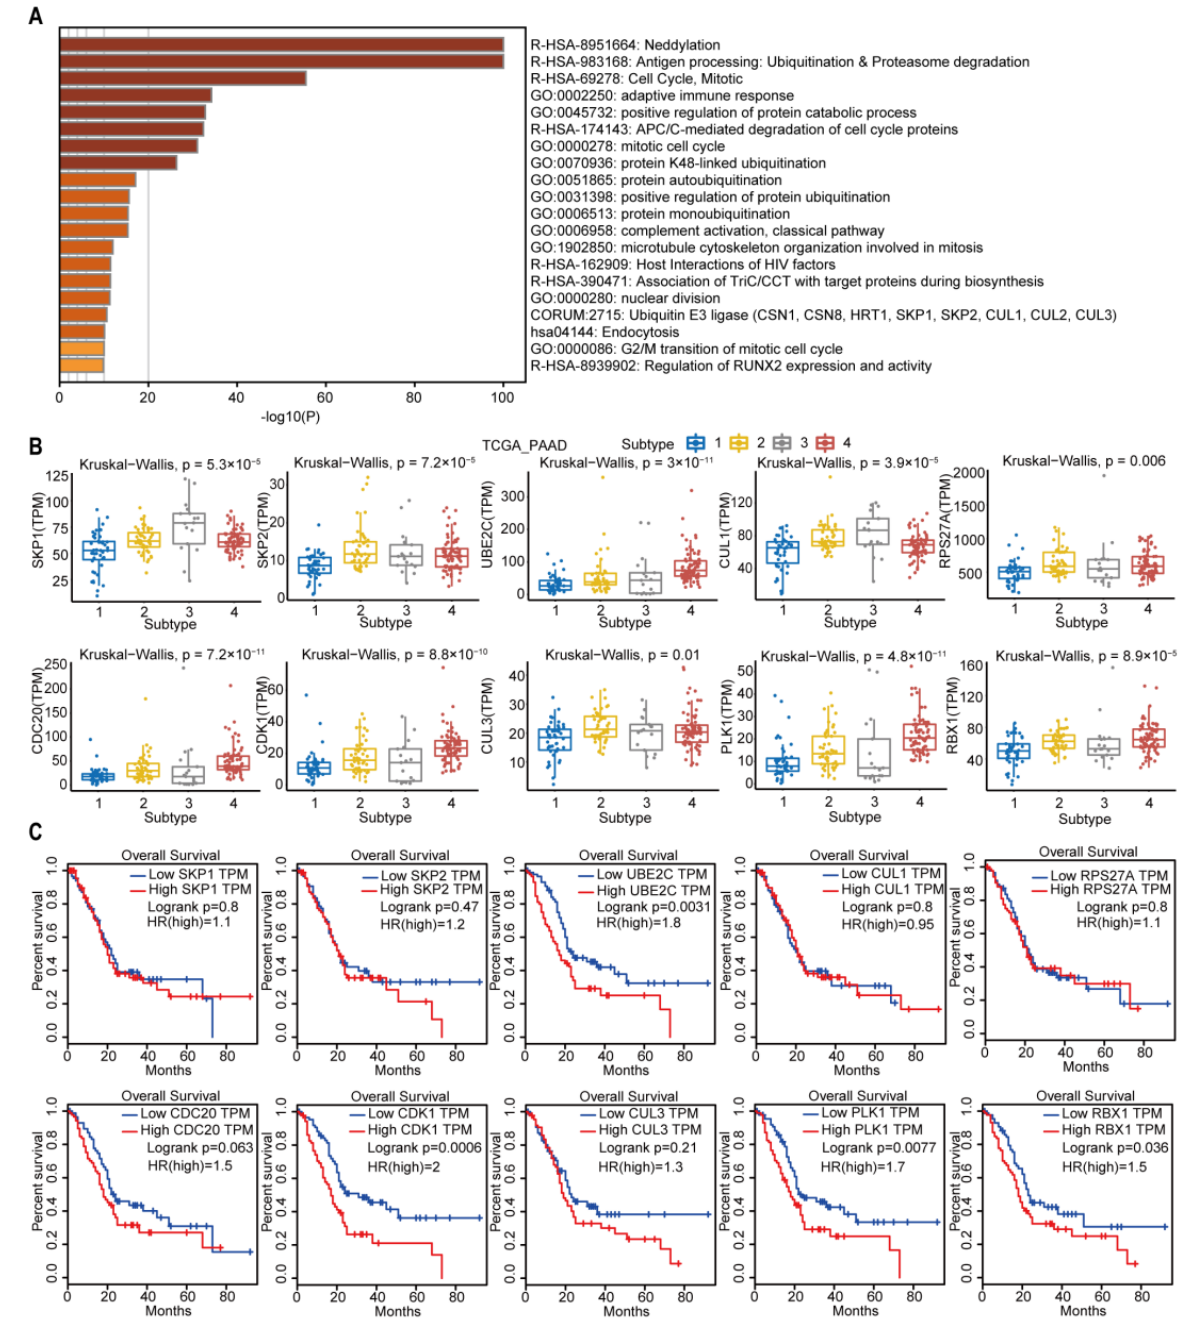
Figure 9. Subtype-3 specific pathways and feature genes. ( A ) pathways enriched in subtype-3. The horizontal axis represents the negative log (base 10) of the p -value. ( B ) The differential expression of feature genes in subtype-3, which had the top 10 highest degree in subtype-specific network. ( C ) Kaplan–Meier curves for the OS of TCGA pancreatic cancer samples showed that higher expressions of UBE2C , CDK1 , PLK1 , and RBX1 were associated with worse outcome. Abbreviations: TPM, transcripts per million; TCGA, The Cancer Genome Atlas; PAAD, pancreatic adenocarcinoma; PLK-1, Polo-like kinase 1; SKP, S-phase kinase-associated protein; CUL, Cullin; RPS27A, ribosomal protein S27a; CDC, cell division cycle; CDK, cyclin dependent kinase; UBE2C, ubiquitin-conjugating enzyme 2C; RBX, ring-box.